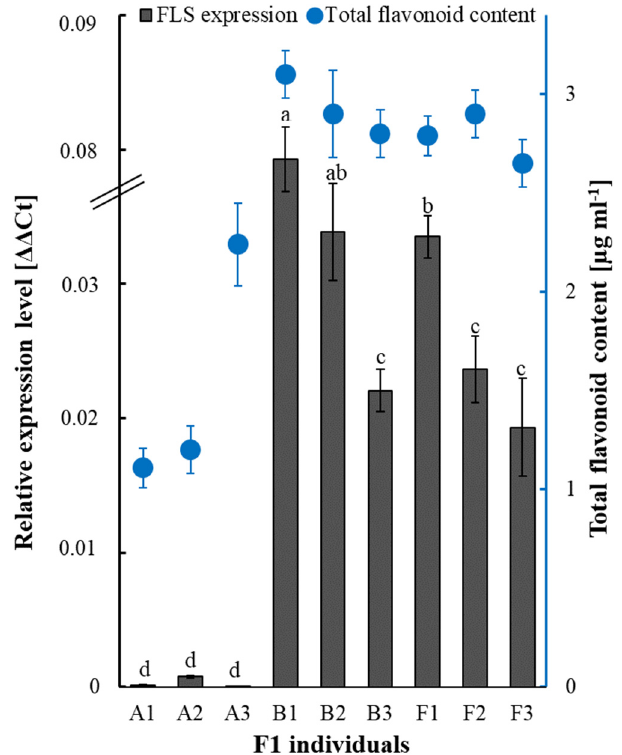
Figure 4. Relative expression level of the FLS gene (left axis) and total flavonoid content (right axis) in F1 individuals assigned to bulks A’, B’, and F’. a, b, c, d: homogeneous groups for FLS expression level (post hoc Tukey’s honestly significant difference (HSD) test); bars: means ± SD.